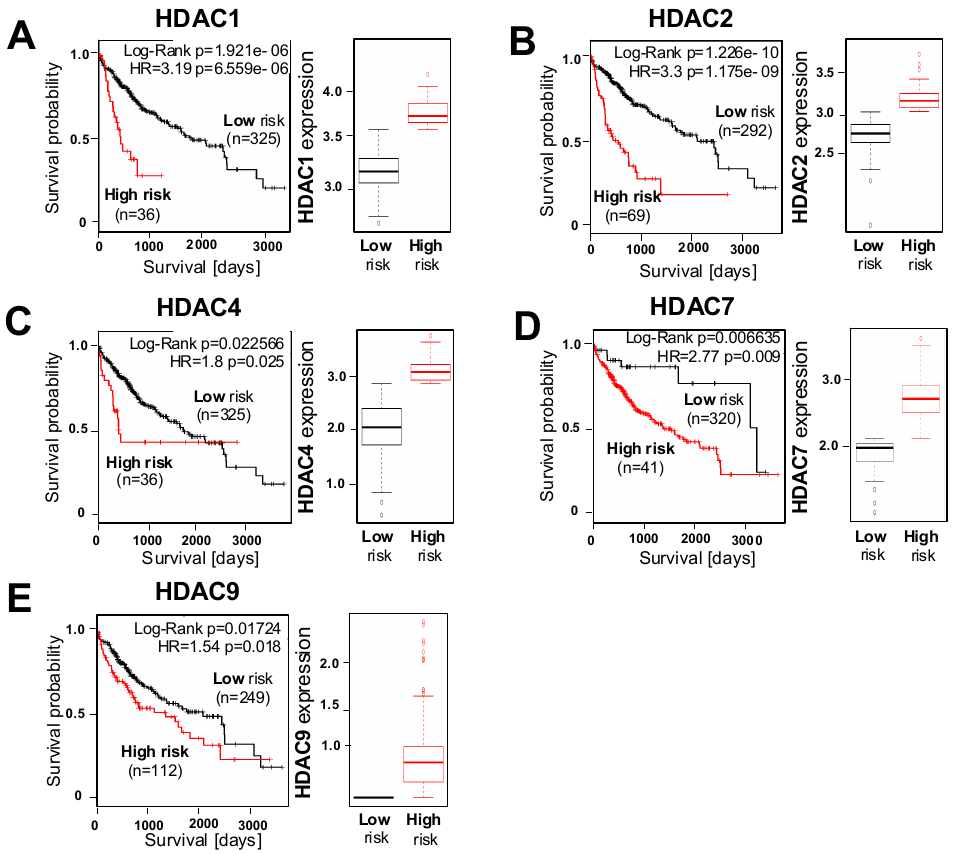
Figure 4. HDAC expression levels and prognosis of HCC patients. ( A–E ) The representative Kaplan–Meier survival curve analysis was performed using the SurvExpress Biomarker validation database for a TCGA HCC (LIHC) dataset (n = 361) for overall survival (left panel) with stratification into ‘low-risk’ and ‘high-risk’ groups based on the prognostic index for different HDACs and the quantification of the corresponding mRNA expression (right panel).